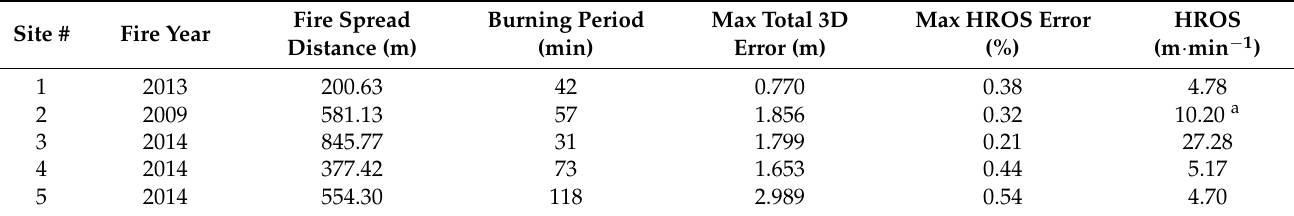
Table 5. Fire behaviour parameters determined from the georeferenced wildfire images.